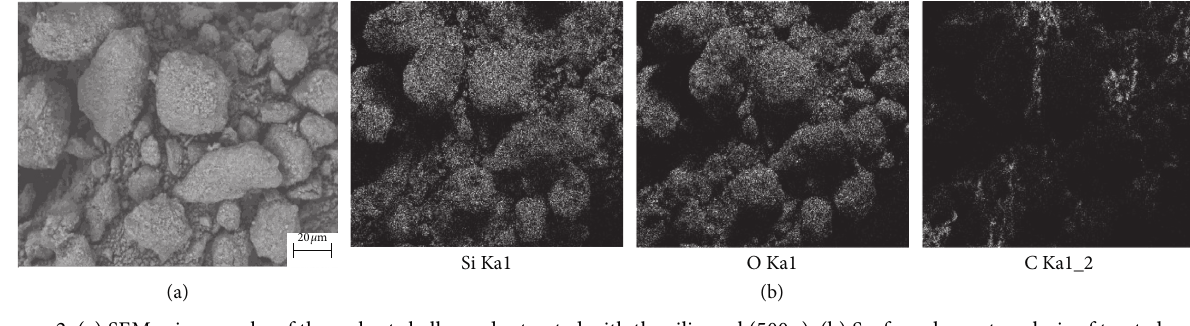
Figure 2: (a) SEM micrographs of the walnut shell powder treated with the silica sol (500 × ). (b) Surface element analysis of treated walnut shell powders with the silica sol.